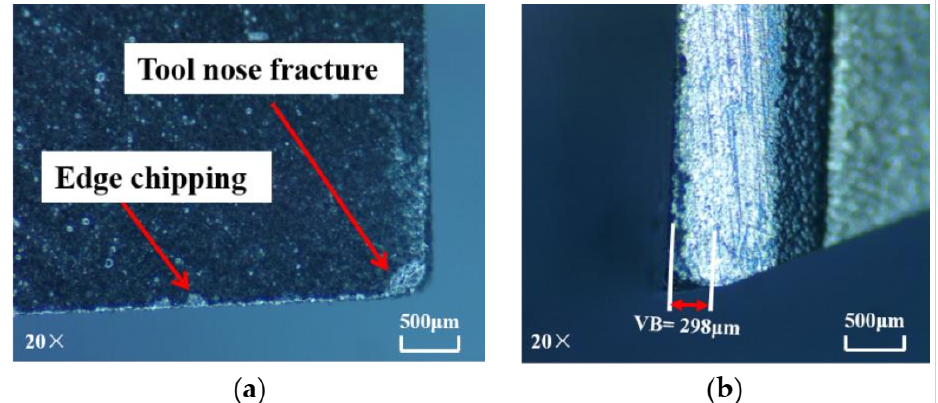
Figure 8. Wear of PCD tool in cryogenic machining: ( a ) rake face; ( b ) flank face (material removal amount = 294 mm 3